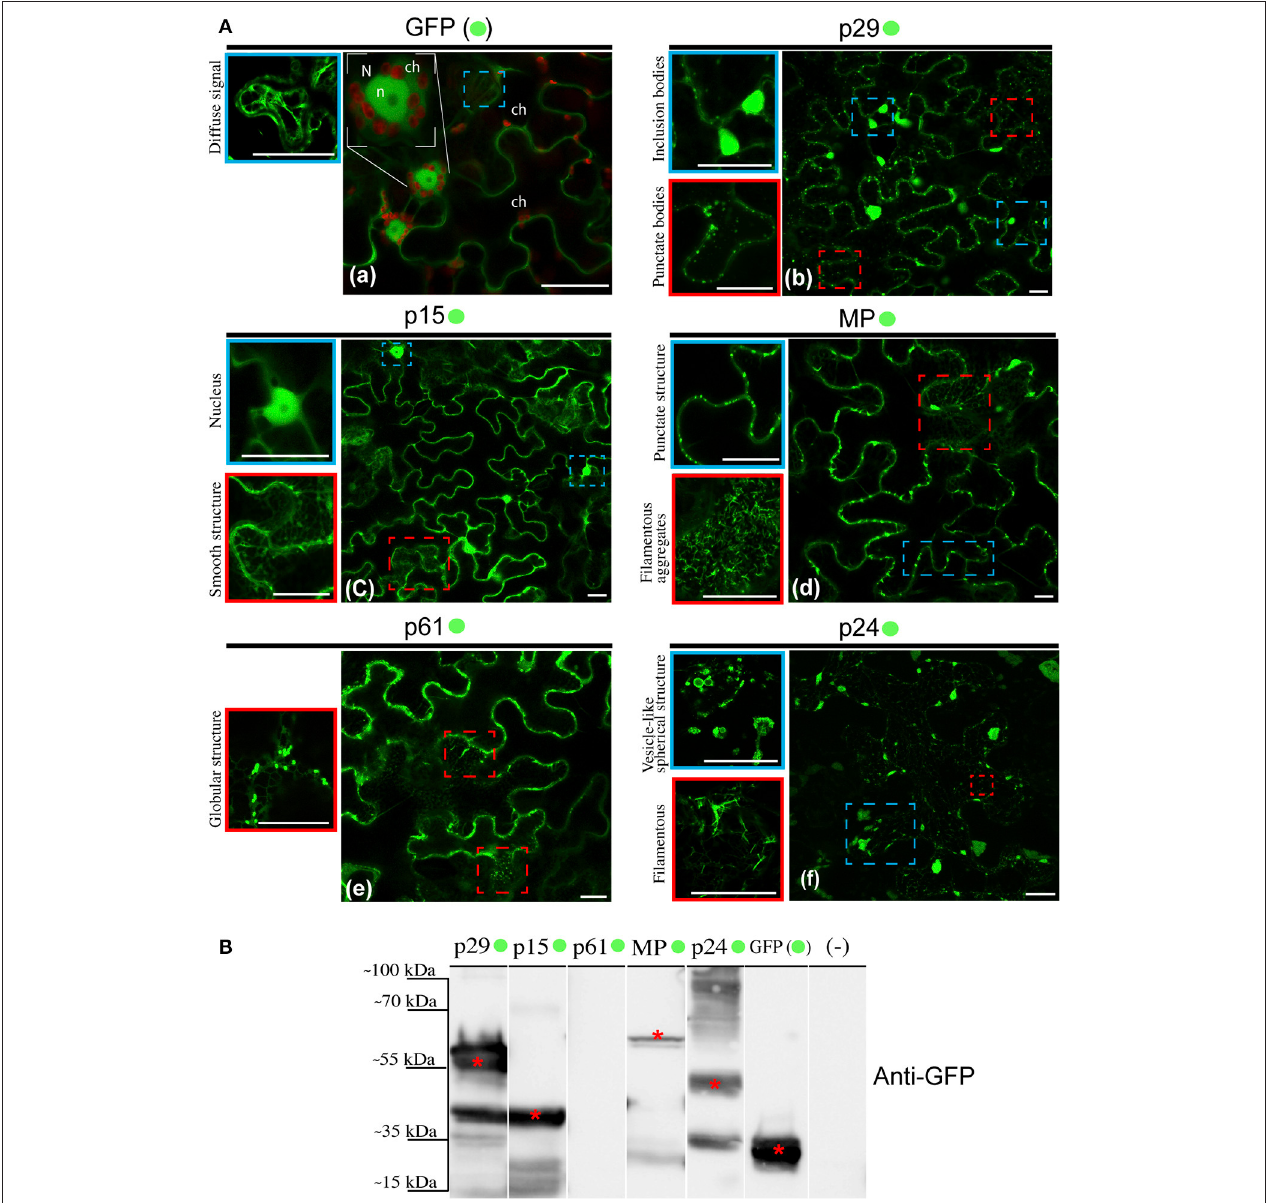
FIGURE 2 | Structure formation and intracellular distribution from transient expression of CiLV-C proteins fused with eGFP and unfused eGFP. (A) Localization analyses from expression of the p29, p15, p61, MP, and p24 CiLV-C proteins fused C-terminal with eGFP (•) in epidermal cell of N. benthamiana . The images shows: (a) Unfused eGFP, which generates a diffuse signal evenly distributed in the cytoplasm (blue box). The nucleolus (n) is visualized internally to the nucleus (N), and auto-fluorescence is observed in the chloroplasts (ch). (b) The presence of p29:eGFP punctate bodies (red box) and inclusion bodies (blue box) dispersed throughout the cytoplasm. (c) The p15:eGFP apparently is organized in a smooth structure that aligns with structures similar to the ER network (red box) and into the nucleus (blue box). (d) The MP:eGFP punctate structures localized at the cellular periphery (blue box), and numerous filamentous aggregates where observed when focused on the cytoplasm region (red box). (e) The p61:eGFP in punctate bodies apparently associated with structures similar to the ER. (f) Formation of vesicle-like spherical (blue box) and filamentous structures (red box) from p24:eGFP expression in the cytoplasm. Images on the left show in higher magnification the respective structures indicated in the blue or red dashed boxes. Fluorescence signals were captured 72h post-infiltration (except for p61, captured 24–36 hpi) with confocal microscope Leica SP8 model. White bars correspond to 50 µ m. (B) Western blot analysis of the transient accumulation of GFP ( ∼ 27 kDa), p29-• ( ∼ 56 kDa), p15-• ( ∼ 42